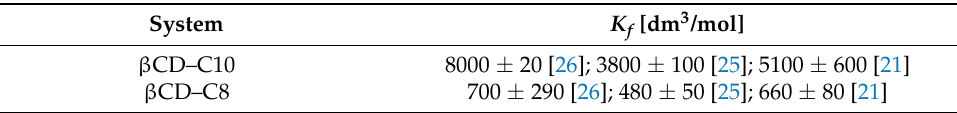
Table 2. Literature values of K f for fatty acids with a carbon chain length of C8 and C10 determined by various physicochemical methods at